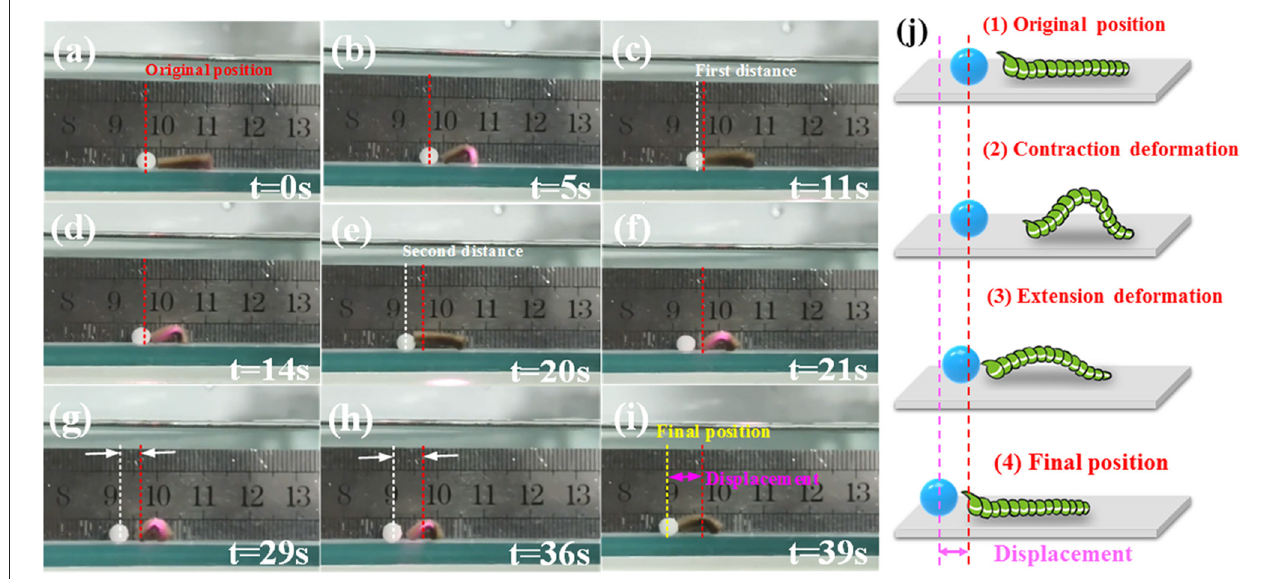
FIGURE 7 | The (a–i) multiple repetitive process and (j) displacement schematic diagram of pushball movement. Arrow represents the boundary of displacement.